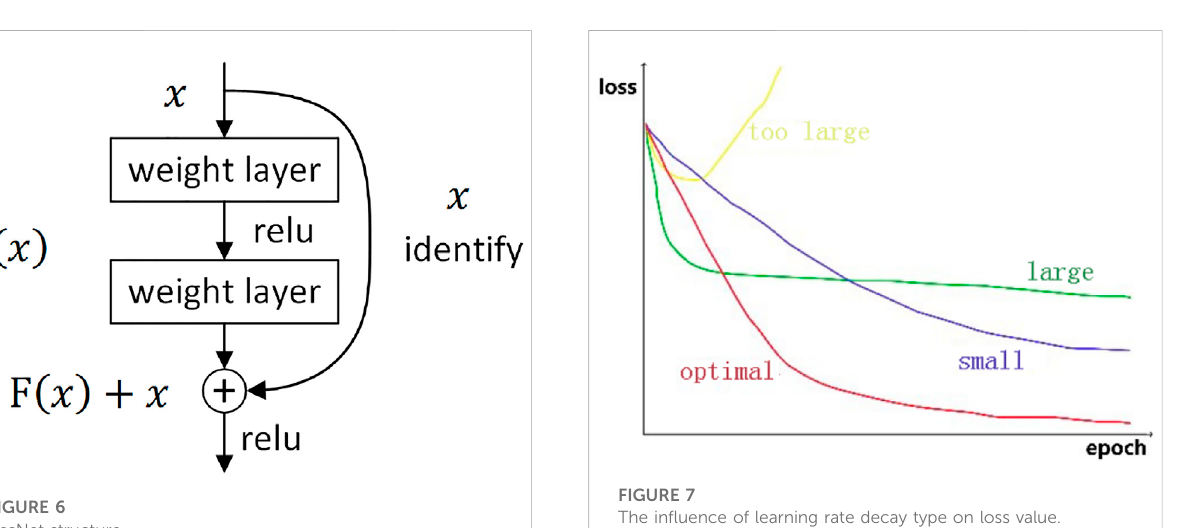
FIGURE 6 ResNet structure.